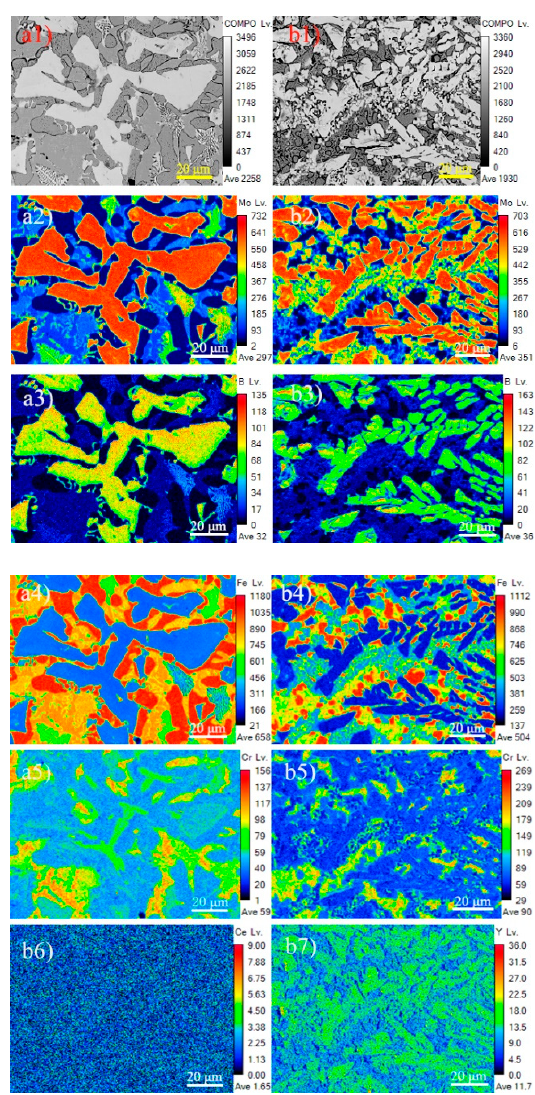
Figure 8. Elements distribution image of cladding with different RE contents: ( a1 ) BSE images of cladding with 0% RE content; ( a2 ) Mo element distribution image of cladding with 0% RE content; ( a3 ) B element distribution image of cladding with 0% RE content; ( a4 ) Fe element distribution image of cladding with 0% RE content;( a5 ) Cr element distribution image of cladding with 0% RE content; ( b1 ) BSE images of cladding with 2% RE content; ( b2 ) Mo element distribution image of cladding with 2% RE content; ( b3 ) B element distribution image of cladding with 2% RE content; ( b4 ) Fe element distribution image of cladding with 2% RE content; ( b5 ) Cr element distribution image of cladding with 2% RE content; ( b6 ) Ce element distribution image of cladding with 2% RE content; ( b7 ) Y element distribution image of cladding with 2% RE content.